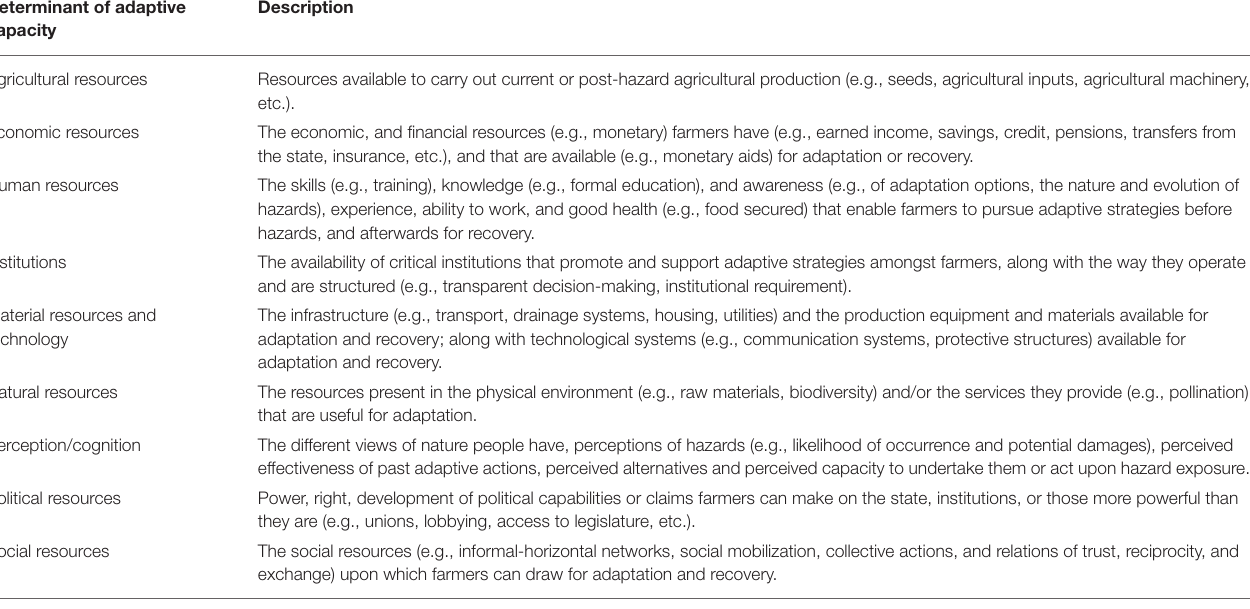
TABLE 1 | Determinants of adaptive capacity as delineated by López-Marrero and Yarnal (2010). Determinant of adaptive